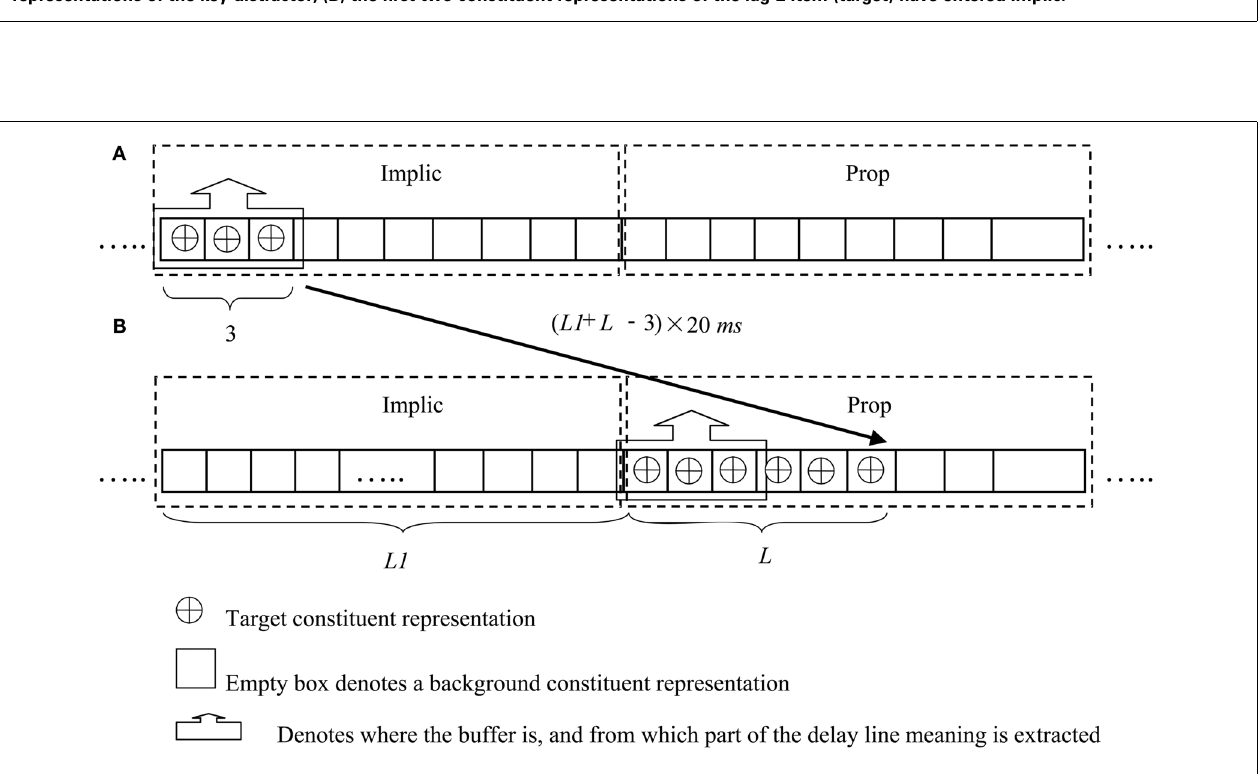
FIGUREA4 | Snapshots of the delay-line when (A) Implic decides to move the buffer to Prop after it has processed the first three constituent